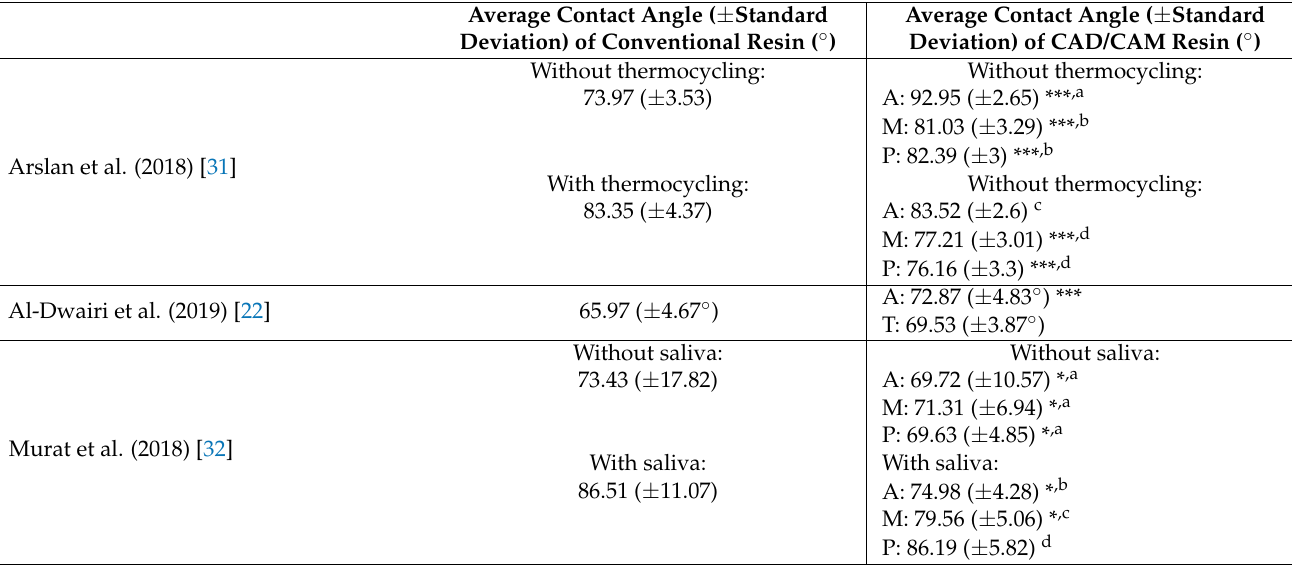
Table 5. Hydrophobicity test